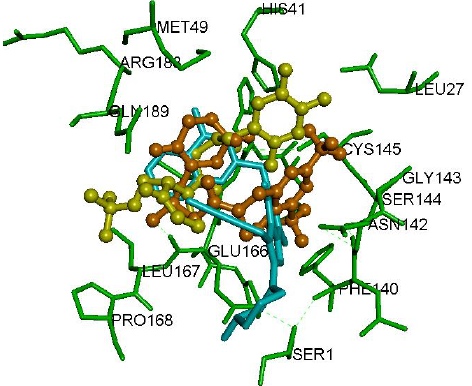
Figure 6. Binding modes of DPP4 inhibitors gemigliptin (orange stick cartoon), linagliptin (blue stick cartoon) and evogliptin (yellow stick cartoon) in the SARS-CoV M pro dimer (PDB ID: 1UK4). Hydrogen atoms are not shown to enhance clarity.